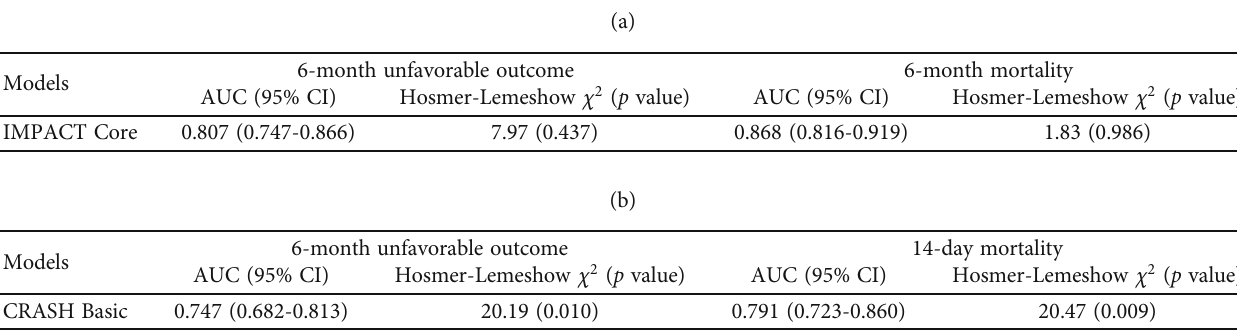
Table 2: Performance measures of IMPACT Core and CRASH Basic models.